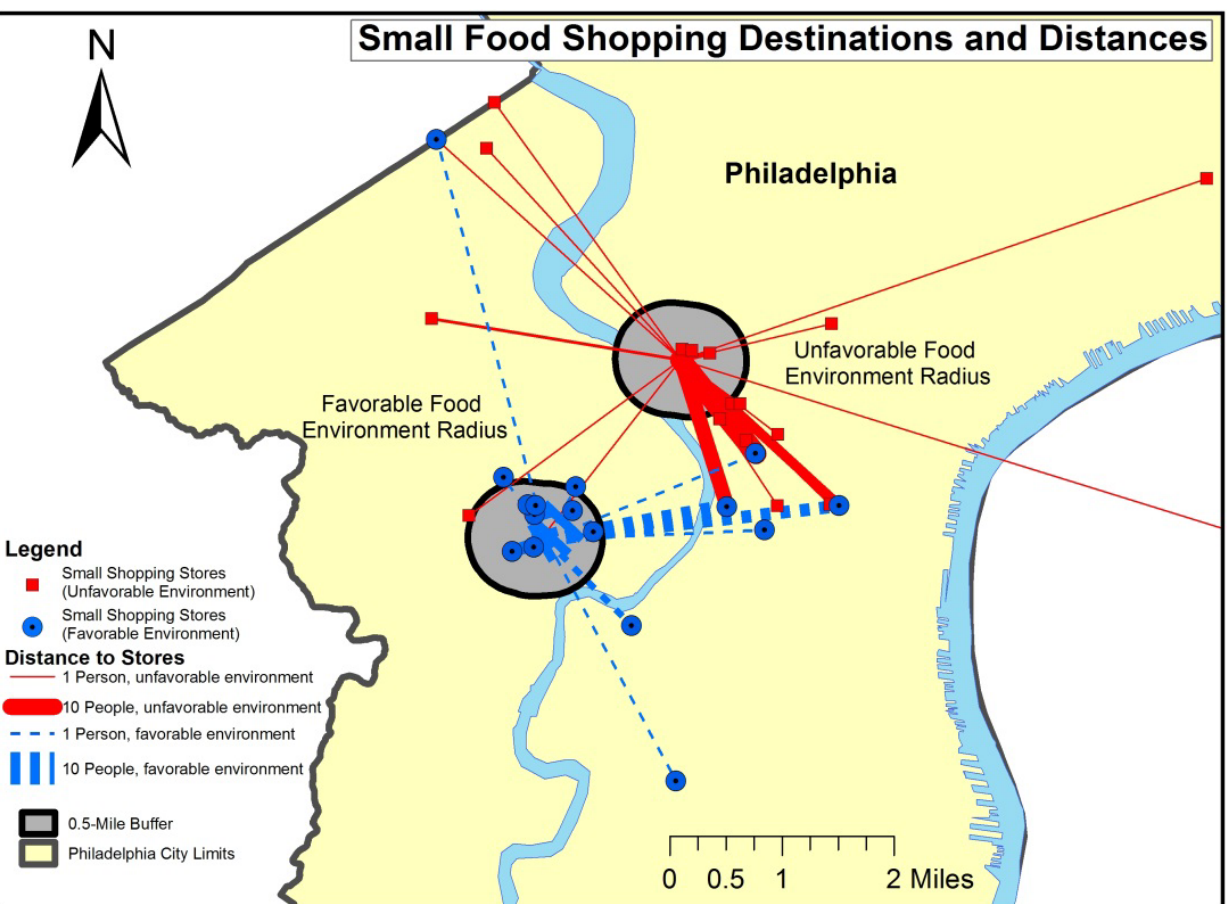
Figure 2. Euclidean distance between the favorable and unfavorable food environment street segments and food stores for small food shopping